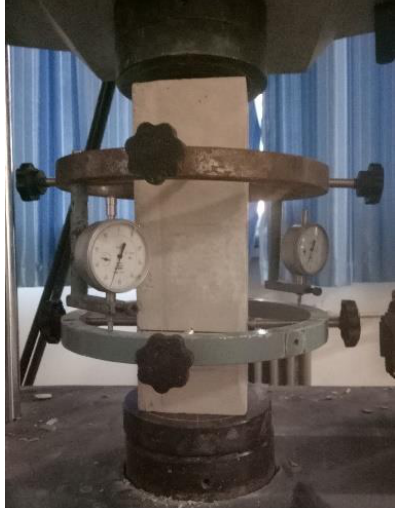
Figure 2. Elastic modulus test of prism.